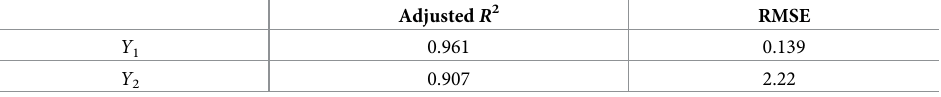
Table 8. Adjusted R 2 and RMSE values for Model W-Outdoor. Y 1 and Y 2 are Δ E , and Δ Gloss 60 ,